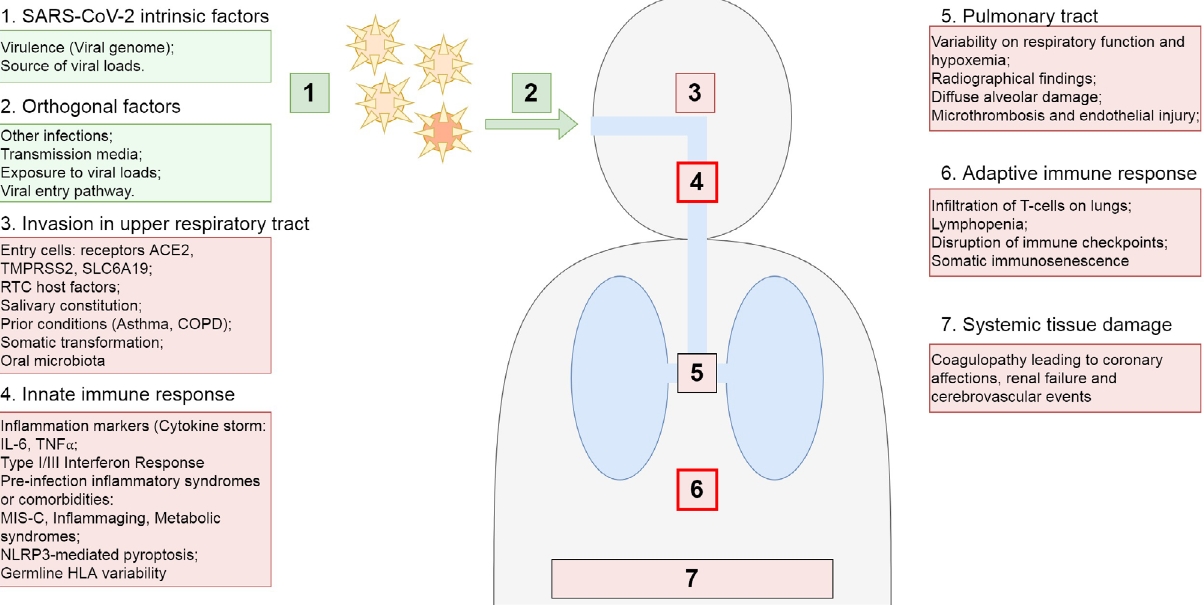
Figure 1 – Factors driving SARS-CoV-2 infection and severity of COVID-19 outcomes. Non-host factors (green) and intrinsic host factors (pink) in seven hypothetical steps that may vary and result in different